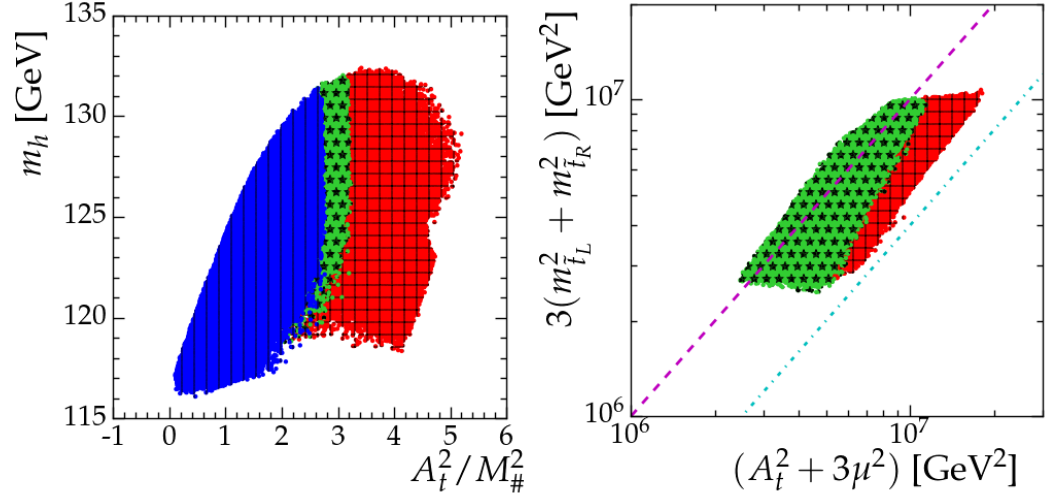
Figure 3 . Left: the variation of m h against A 2 =M 2 for the four (cid:12)eld potential. Right: the variation t # of 3( m 2 + m 2 ) with A 2 + 3 (cid:22) 2 for the four (cid:12)eld potential. The dashed (magenta) line corresponds t ~ t L ~ t R to the analytic bound and the dot-dashed (cyan) line corresponds to the empirical bound. Points that correspond to the EWSB vacuum being unstable are given in red (checkered), meta-stable in green (stars) and stable in blue (vertical lines).